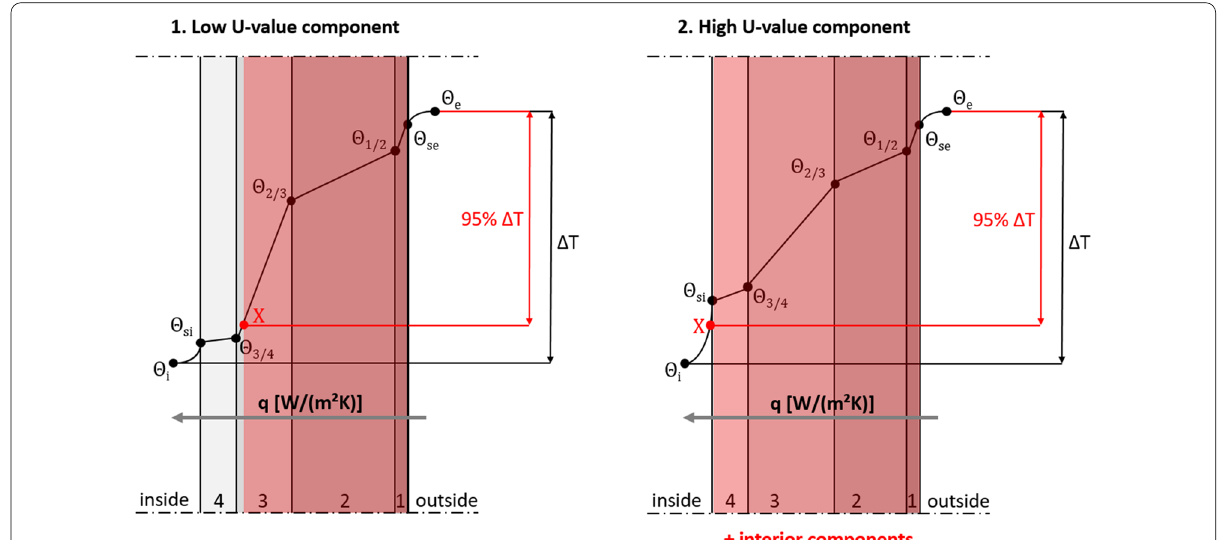
Fig. 4 Display of the outer wall with the point X in question and red marking of the respective component cross-section of the outer wall that stores